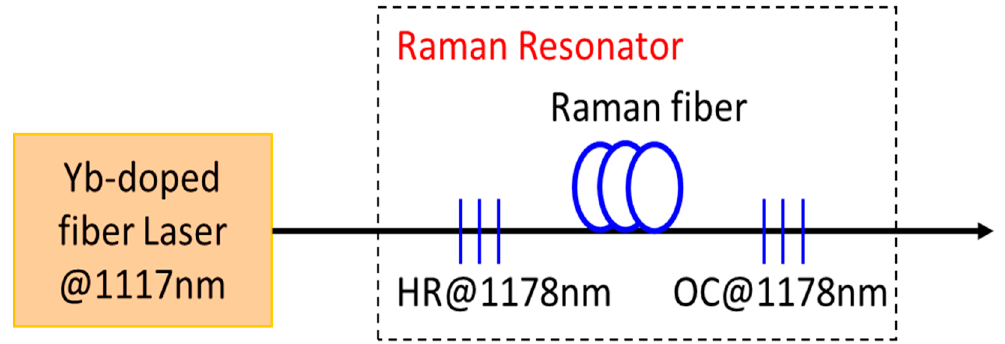
Schematic representation of a Raman fiber laser with one wavelength shift. (HR—high-reflectivity fiber Bragg grating, OC—output coupler—a low-reflectivity fiber Bragg grating).